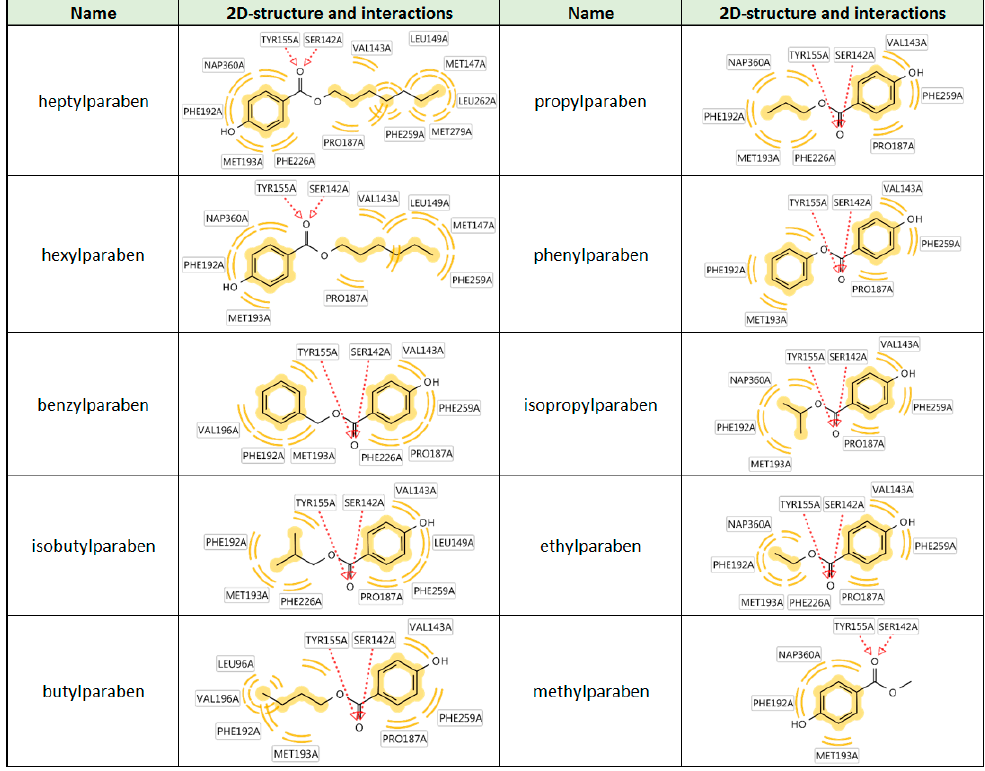
Figure A1. Predicted protein-ligand interactions of the tested parabens with the 17 β -HSD1 binding site (S-docking).